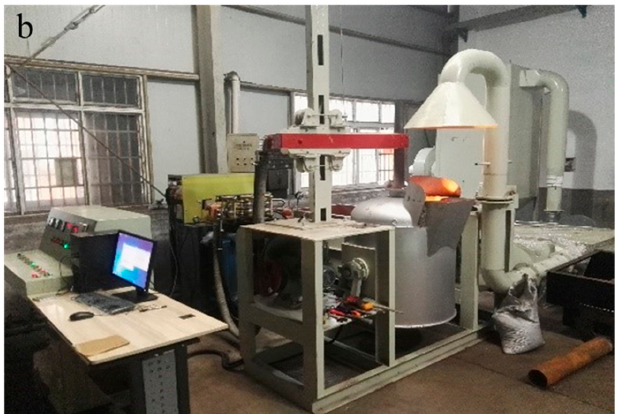
Figure 10. ( a ) Schematic diagram and ( b ) image of the electric arc furnace.